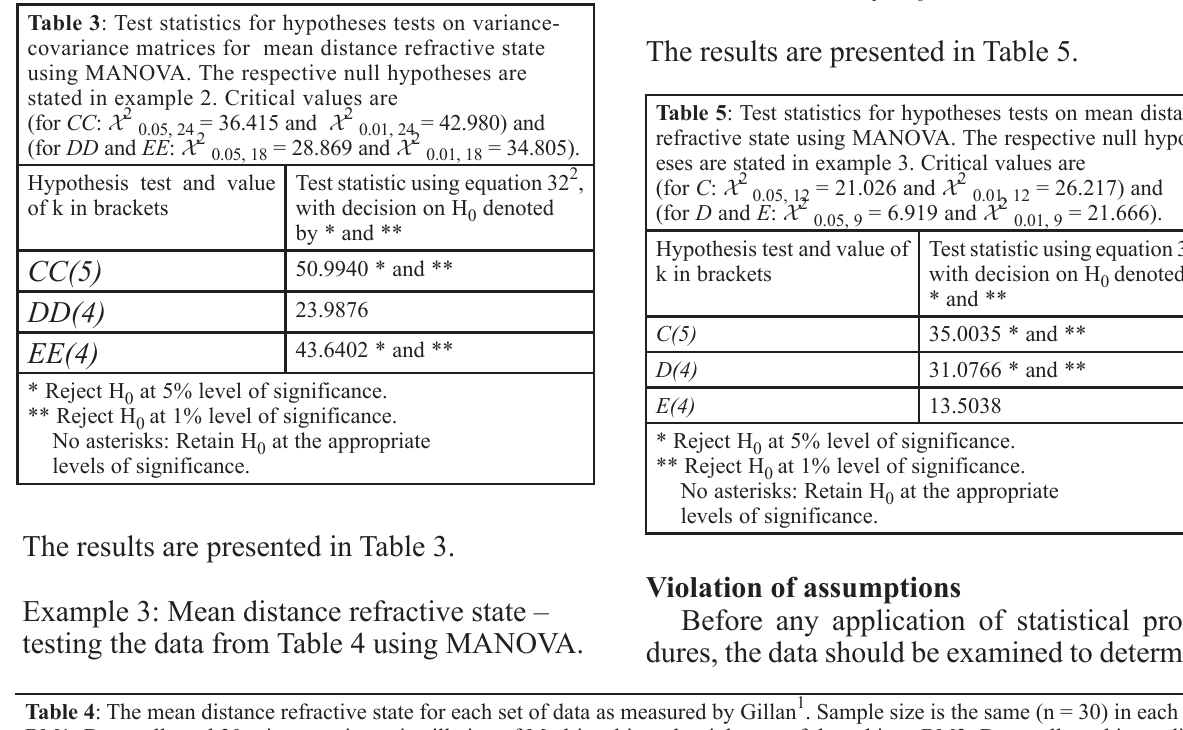
Table 4 : The mean distance refractive state for each set of data as measured by Gillan 1 . Sample size is the same (n = 30) in each case. BM1: Data collected 30 minutes prior to instillation of Mydriacyl into the right eye of the subject, BM2: Data collected immediately prior to instillation, AM1: Data collected 15 minutes after instillation, AM2: Data collected 30 minutes after instillation and AM3: Data collected 60 minutes after instillation. All quantities have units D, except for axis which is measured in degrees. Mean distance refractive state (conventional form) Mean distance refractive state as vector h